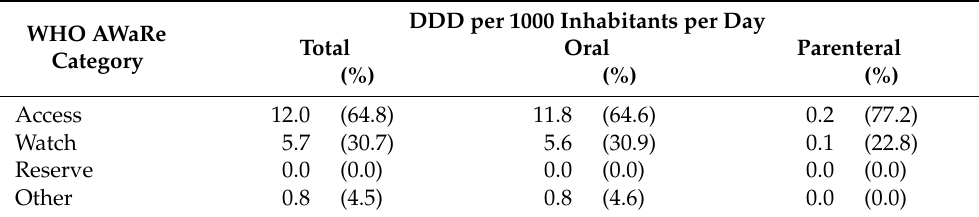
Table 2. Total consumption of antibiotics (J01) per defined daily dose (DDD) per 1000 inhabitants per